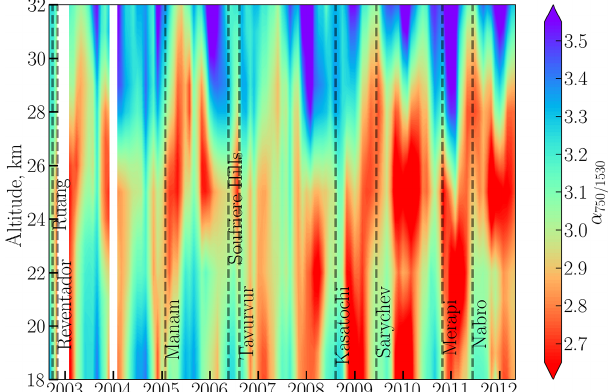
Figure 10. Deseasonalized time series (anomalies) of the Ångström exponents ( α 750 / 1530 ) derived from SCIAMACHY limb data in the tropics (20 ◦ N–20 ◦